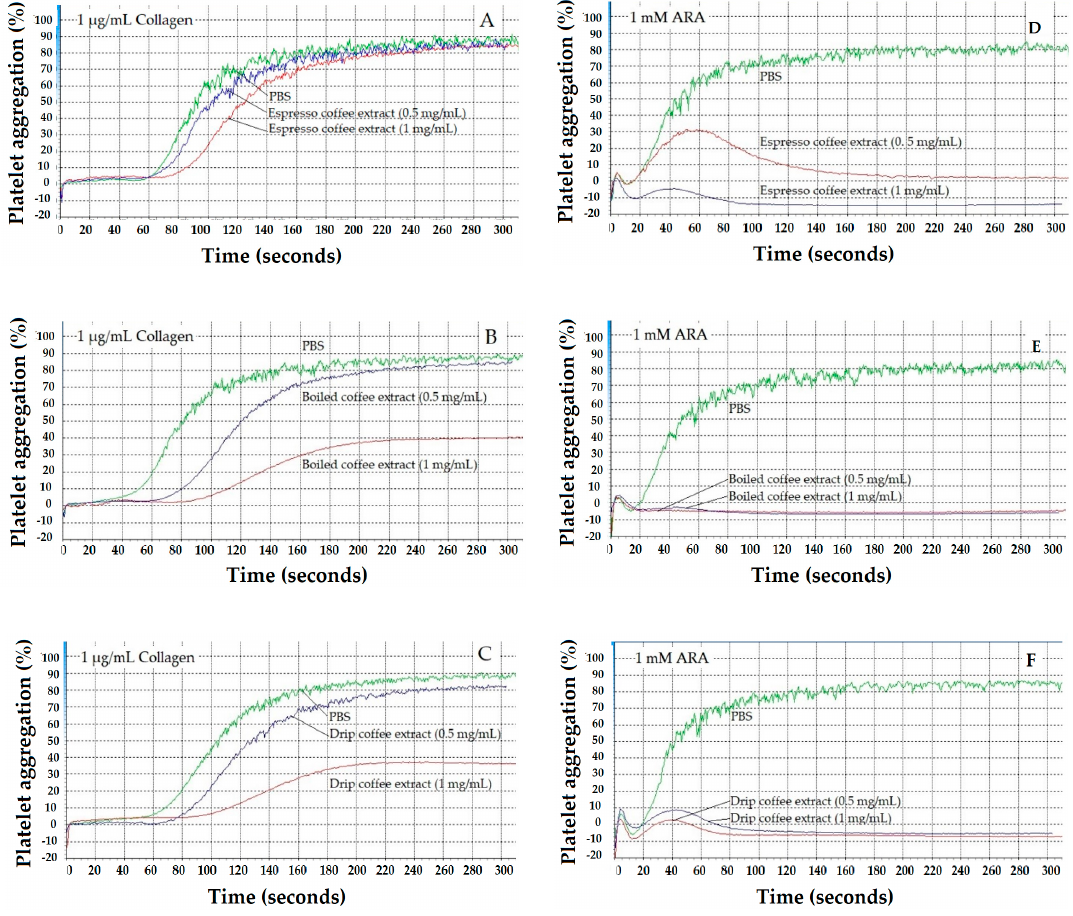
Figure 5. Representative aggregation traces of collagen ( A – C ) and sodium arachidonate (ARA)( D – F )-induced platelet aggregation by espresso, boiled, and drip coffee extracts (1 mg/mL each). Data were obtained from three platelet-rich plasma samples and are presented as mean ± SEM values.